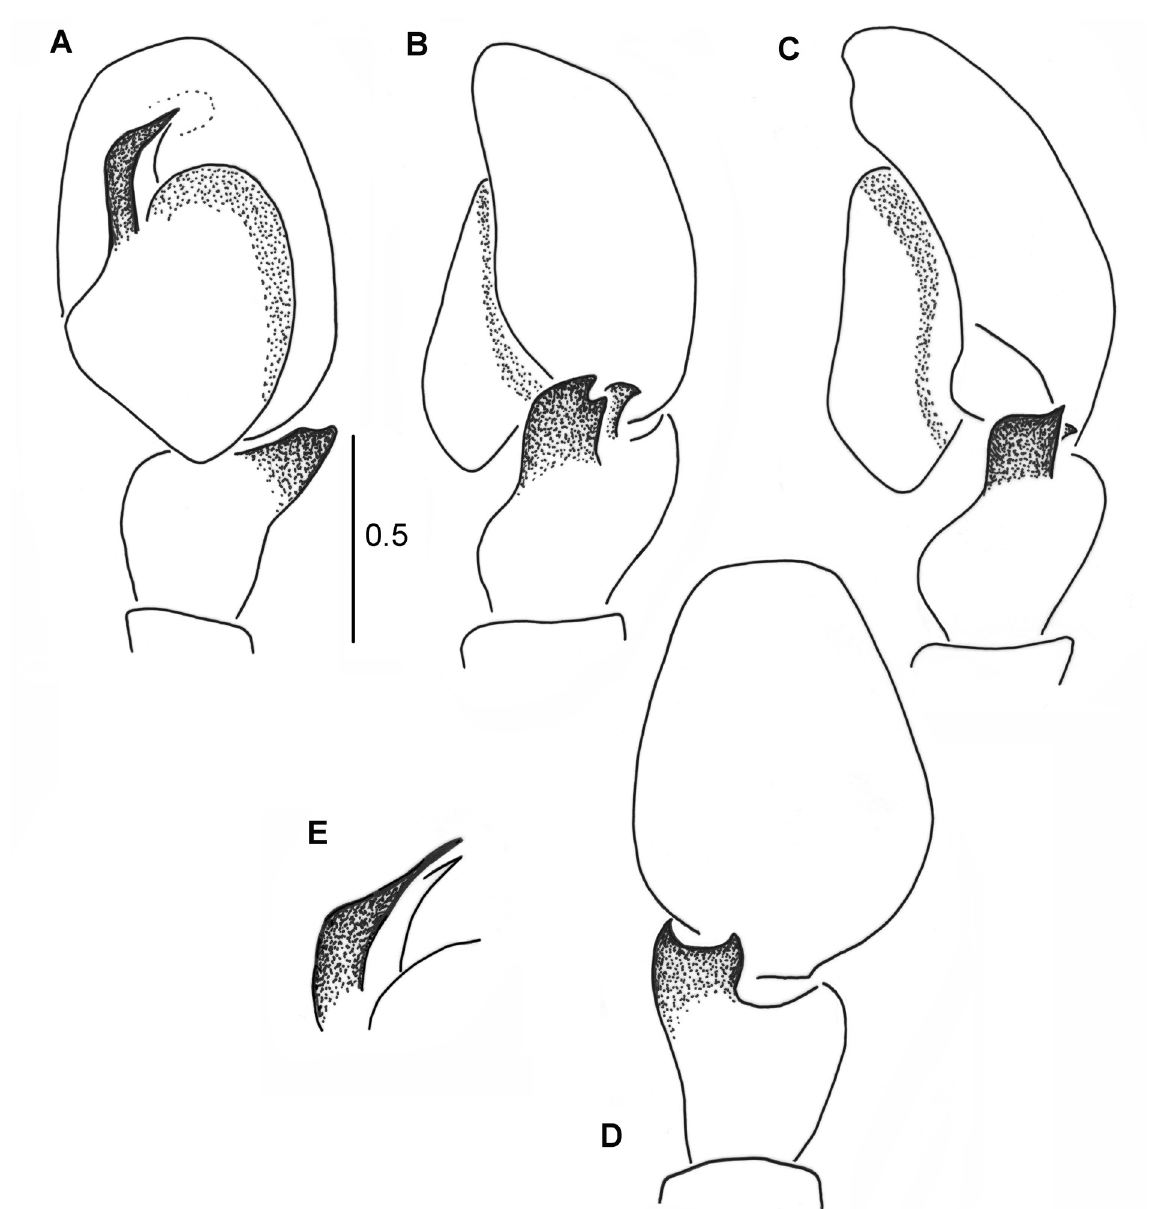
Fig. 14. Dasycyptus dimus Simon, 1902, ♂ (MNHN). A . Palpal organ, ventral view. B–C . Palpal organ, lateral view. D . Palpal organ, dorsal view. E . Embolic